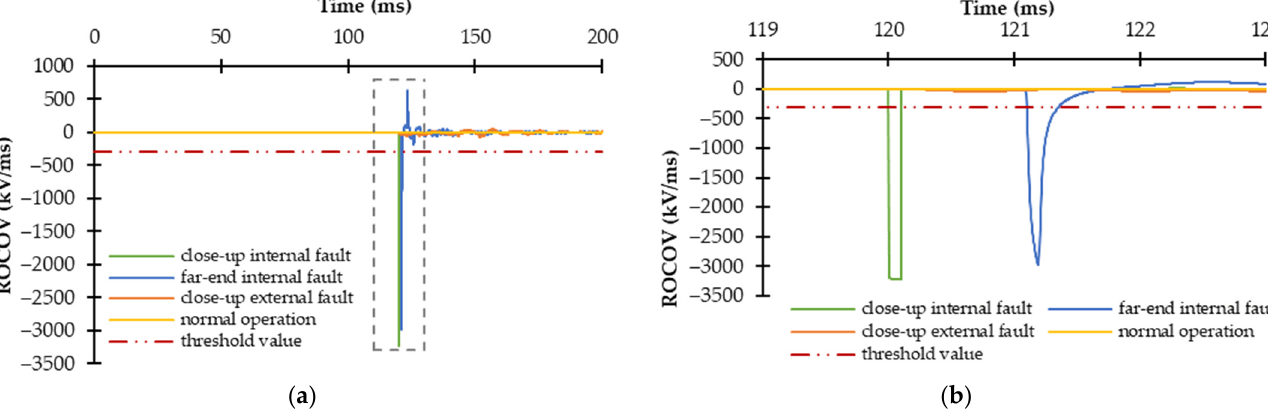
Figure 3. (a ) ROCOV values for different fault conditions and ( b ) zoom in dashed line square between 199 and 123 ms.